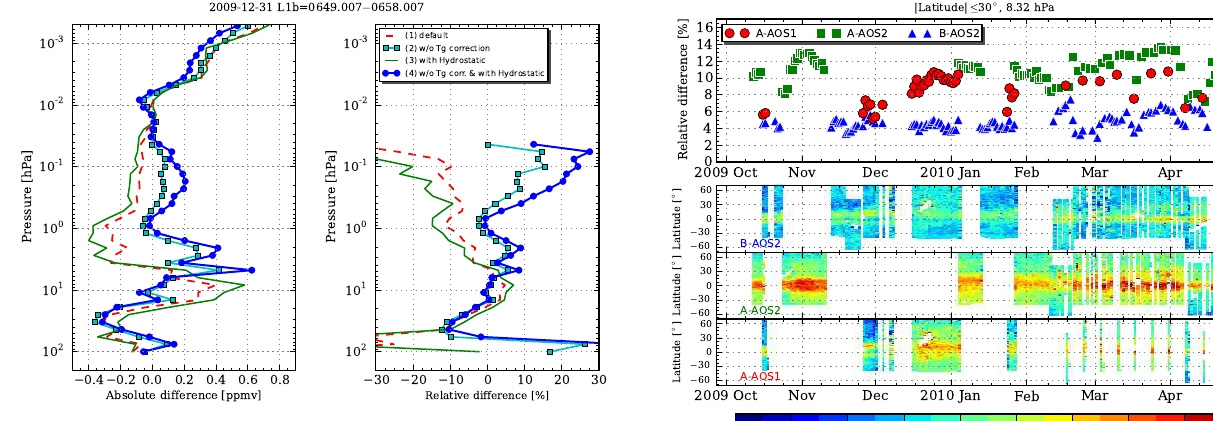
Fig. 9. Difference in the O 3 profiles retrieved in the SMILES(NICT) and SMILES(JAXA) processing when changing the tangent height correction method and adding the hydrostatic equilibrium condition for the SMILES(NICT) processing. Analysis of ten Band-B scans from 31 December 2009 were averaged. The original SMILES(NICT)–SMILES(JAXA) O 3 difference is shown in the red dashed curve as reference. The cases for the SMILES(NICT) processing without the tangent height correction, and with the hydrostatic equilibrium condition are shown in the cyan profile with square symbols and the green solid profile, respectively. The blue profile with dot symbols represents the case with no tangent height correction and with the hydrostatic equilibrium condition included.